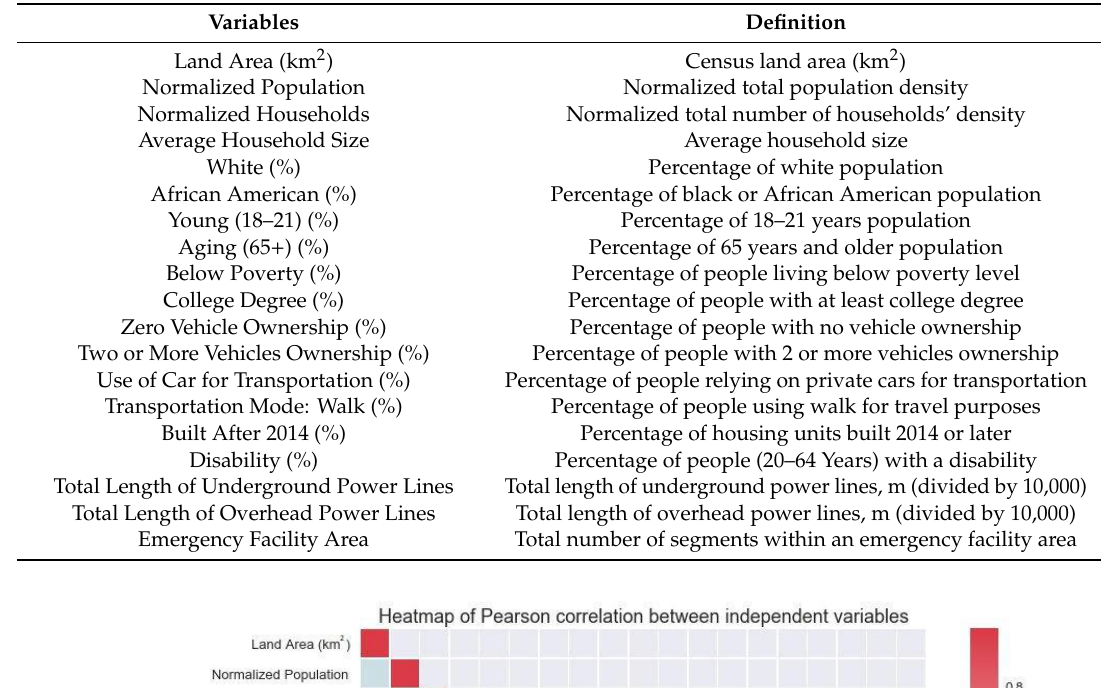
Table 1. Definitions of independent variables.